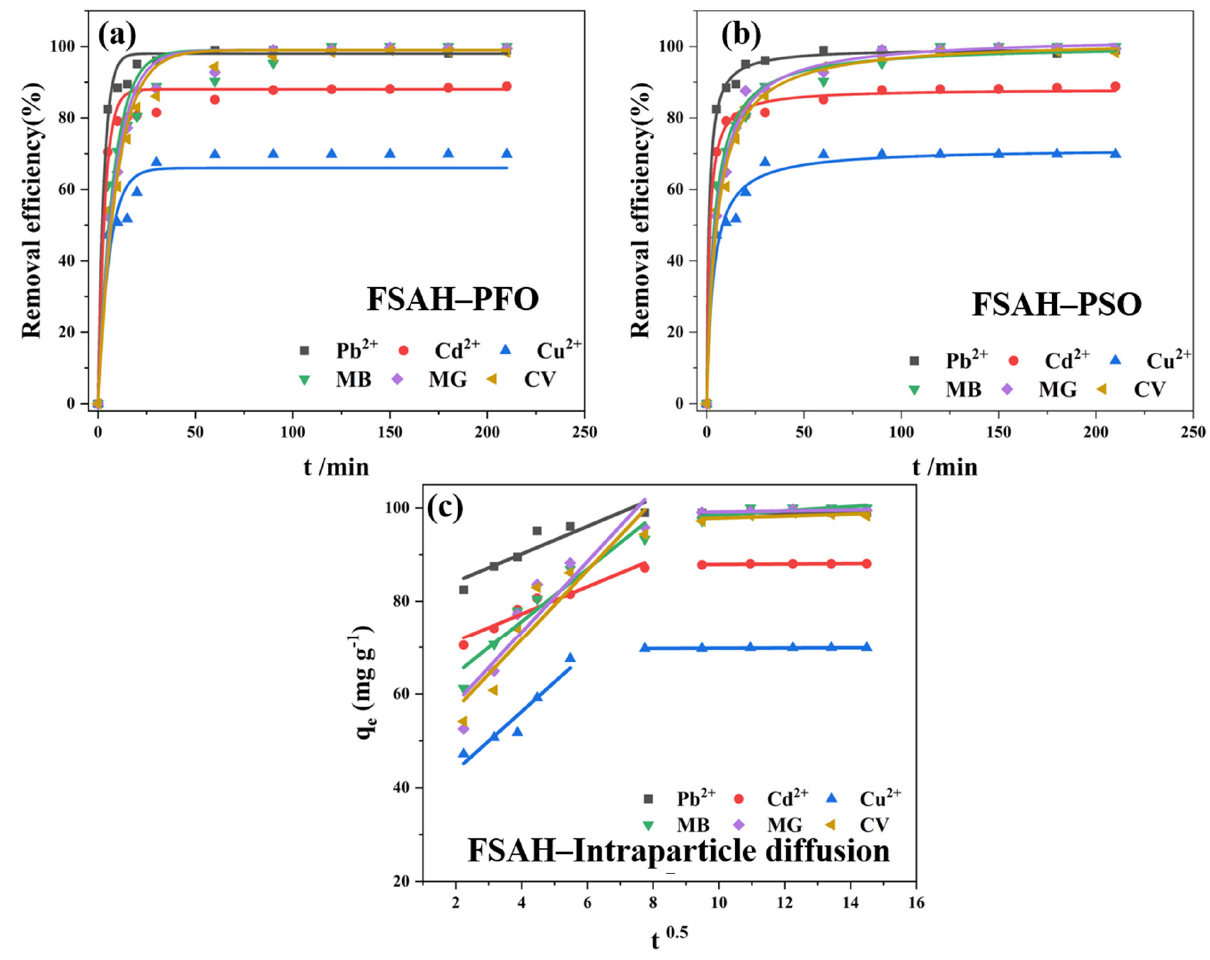
Figure 6. The PFO ( a ) and PSO kinetic plots ( b ), the intraparticle diffusion plots ( c ) for heavy metals and cationic dyes onto FSAH.